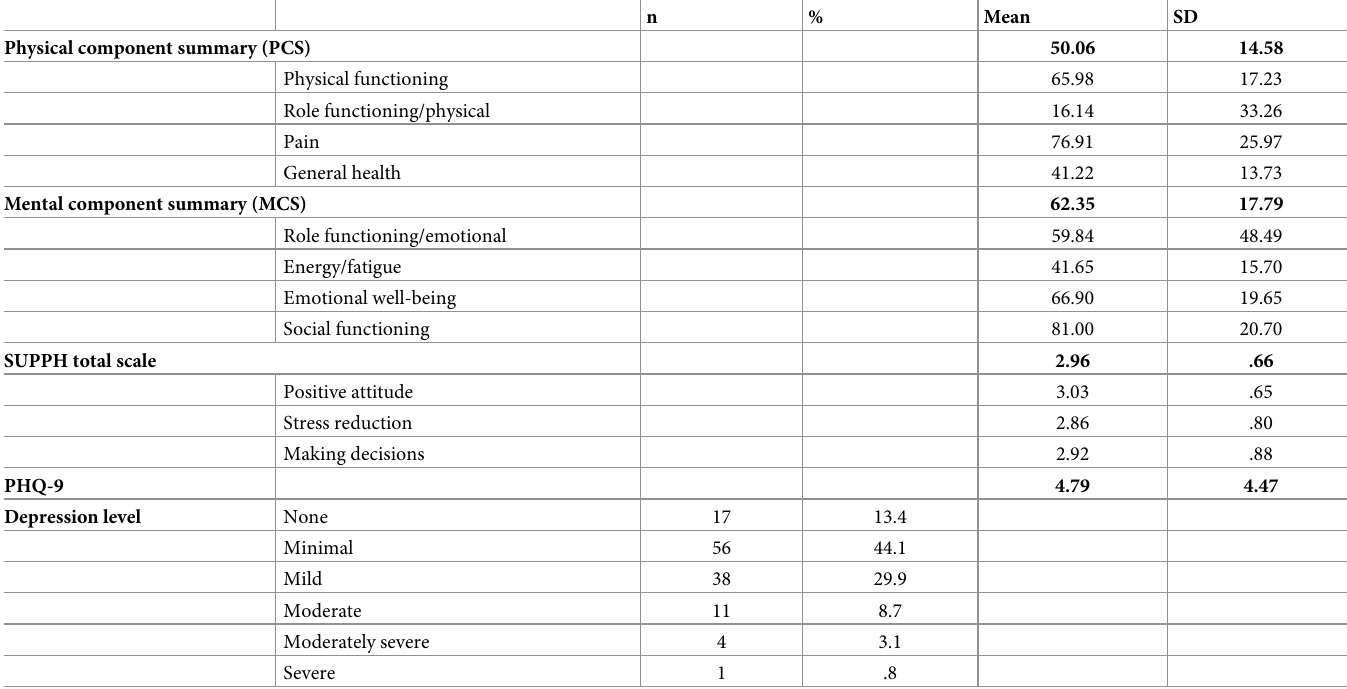
Table 2. Descriptive statistics for QoL, self-care self-efficacy (SUPPH scale), and depression (PHQ-9) ( n = 127). Physical component summary